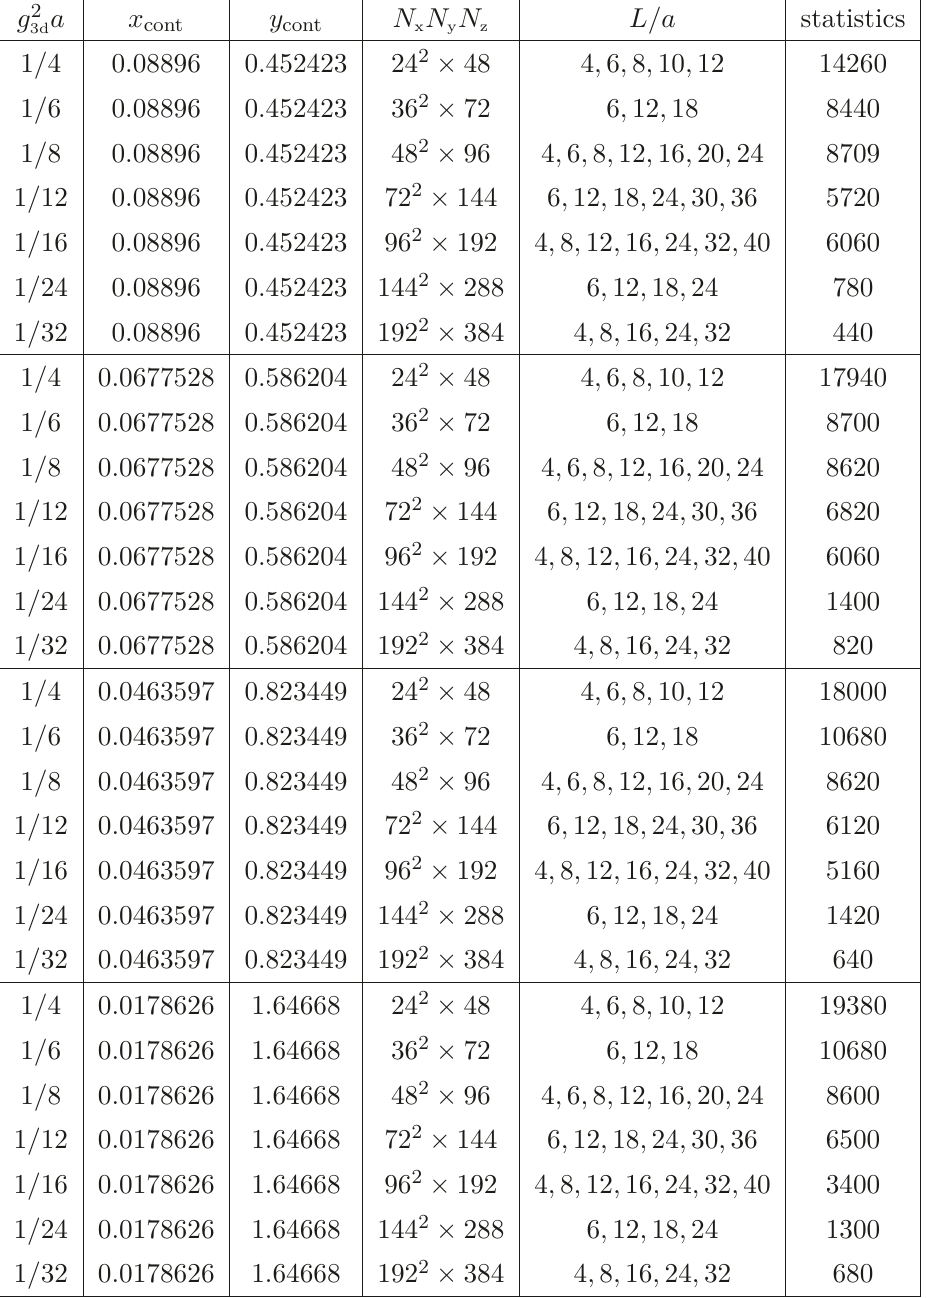
Table 4 . Parameters for all EQCD multi-level simulations. We give the continuum expressions for the rescaled quartic scalar self-coupling x into lattice units is done using the respective lattice-continuum relations [33,